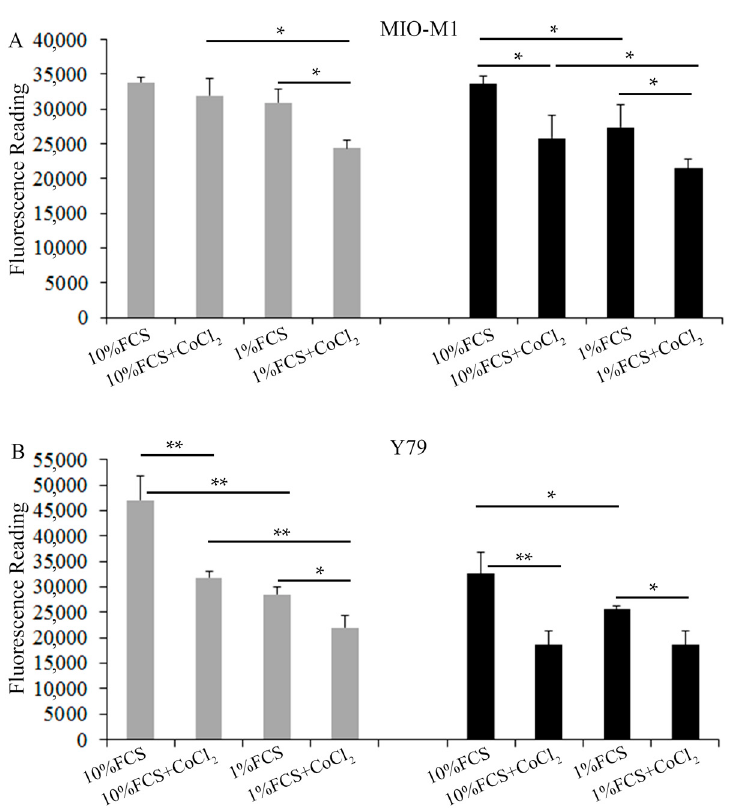
Figure 1. Effects of serum starvation, high glucose and hypoxia on cell survival of Müller cells and photoreceptors. Cell survival was measured by calcein-AM cell viability assays 24 h after incubating cells in test media. ( A ) Müller cell viability assays. Grey bars: 5 mM glucose. Black bars: 25 mM glucose. * p < 0.05, n = 6/group; ( B ) Y79 cell viability assays. Grey bars: 11 mM glucose. Black bars: 25 mM glucose. * p < 0.05 and ** p < 0.01 respectively, n = 6/group. FCS, fetal calf serum.